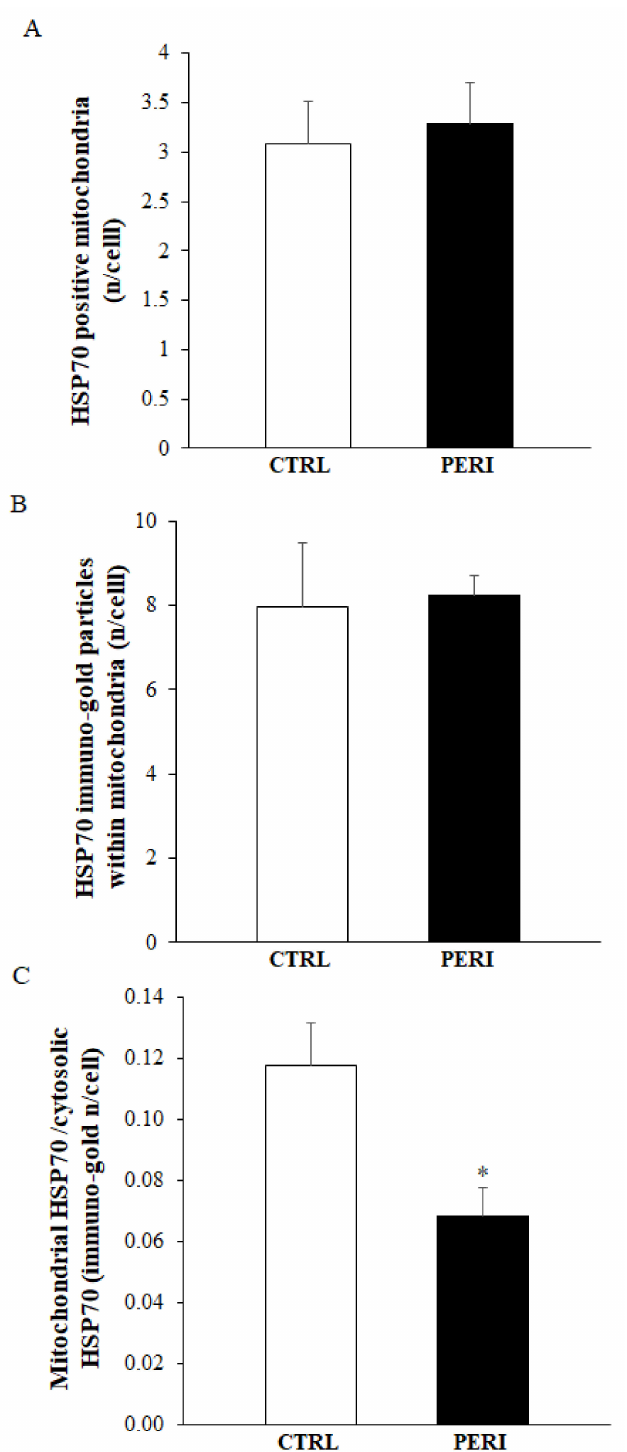
Figure 9. Polarization graphs for HSP70 within mitochondria in the dorsal cerebral cortex. Graphs report the HSP70-positive mitochondria ( A ), the HSP70 immuno-gold particles within mitochondria ( B ) and the ratio of mitochondrial to cytosolic HSP70 immuno-gold particles ( C ). Dorsal placement of area penumbra was dissected in the ipsilateral hemi-encephalon of ischemic mice ( n = 3); analogous area was analyzed from the contralateral side. * p ≤ 0.05 compared with the contralateral dorsal cerebral